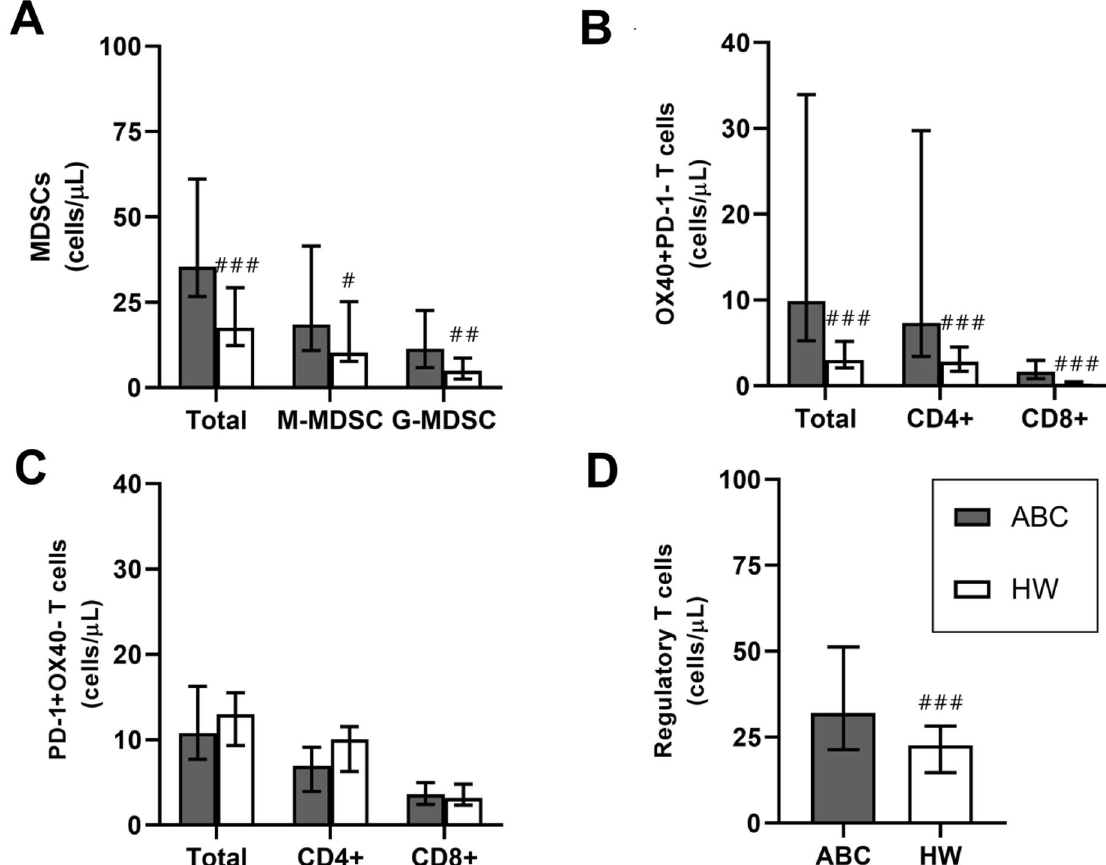
Figure 3. Basal medians of MDSCs, OX40 + , PD-1 + and regulatory T lymphocytes levels (cells/ul) in ABC patients and HW. MDSCs, myeloid derived suppressor cells; M‑MDSC, monocytic MDSCs; G‑MDSC, granulocytic MDSCs; ABC, advanced breast carcinoma; HW, healthy women. #, ## and ###, p ≤ 0.05, p ≤ 0.01 and p ≤ 0.001 compared with ABC patients. Different scales are used